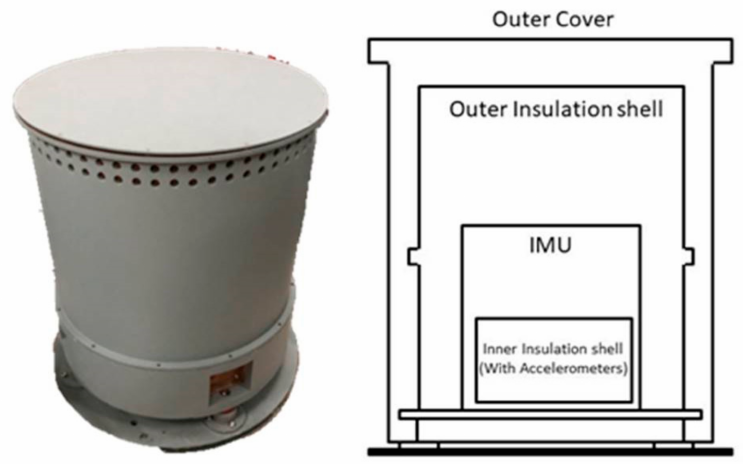
Figure 4. The profile of the INS with precise temperature control